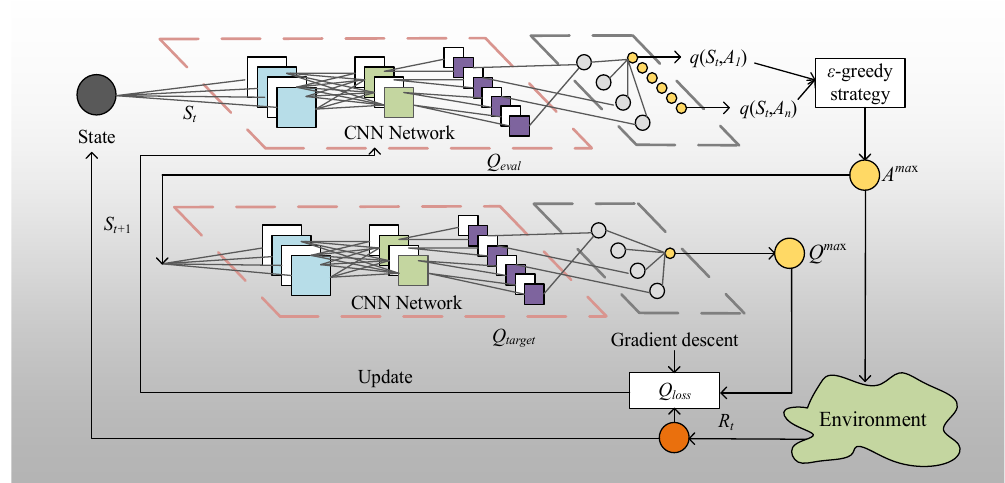
Figure 3. The principle diagram of DDQN.